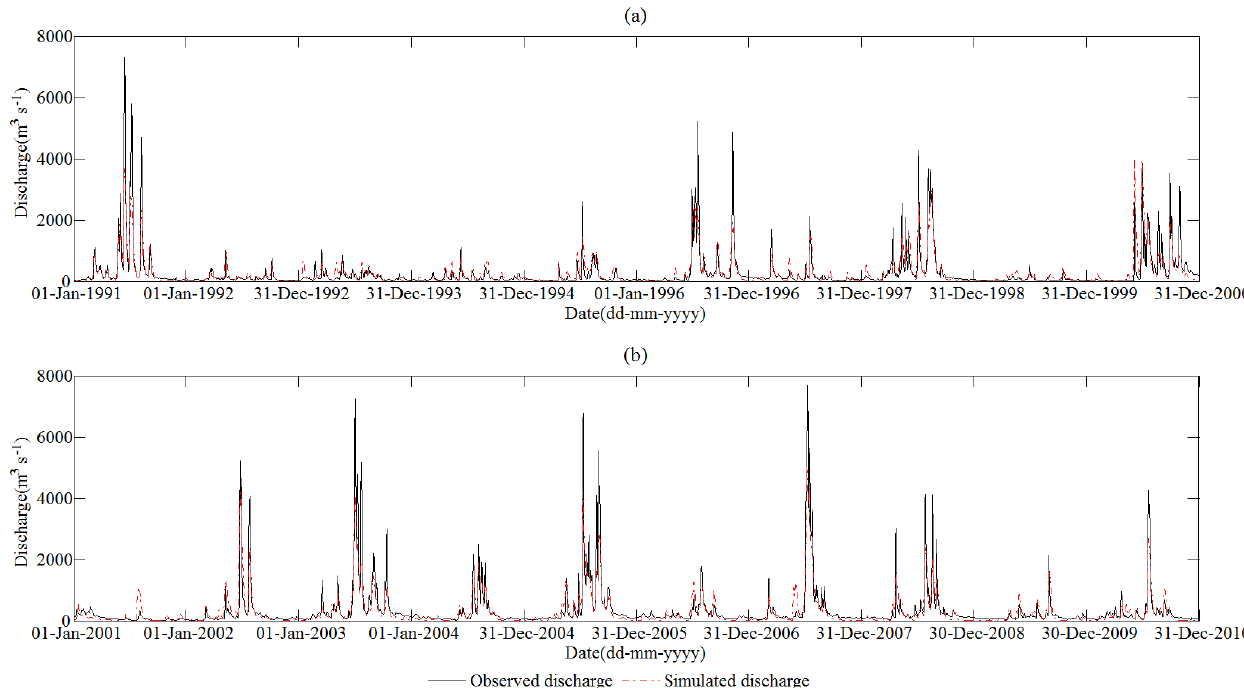
Figure 5. Comparisons between the observed and simulated daily discharges for calibration (a) and validation (b) periods at WJB.